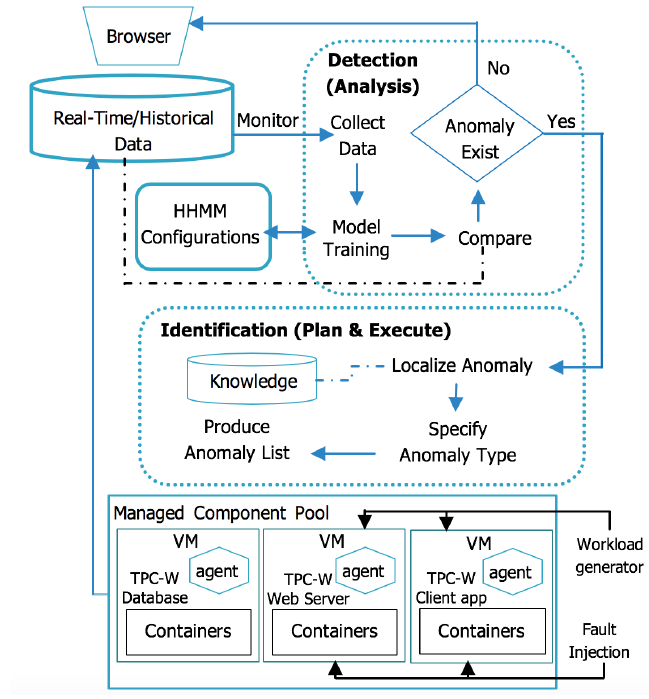
Figure 2. Anomaly detection-identification